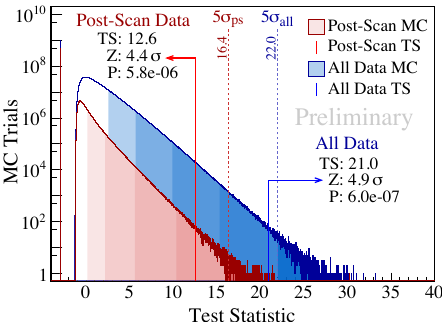
Figure 6: The Monte Carlo determination of the post-scan (red) and all-data (blue) significance with 1 and 10 billion randomized skies,